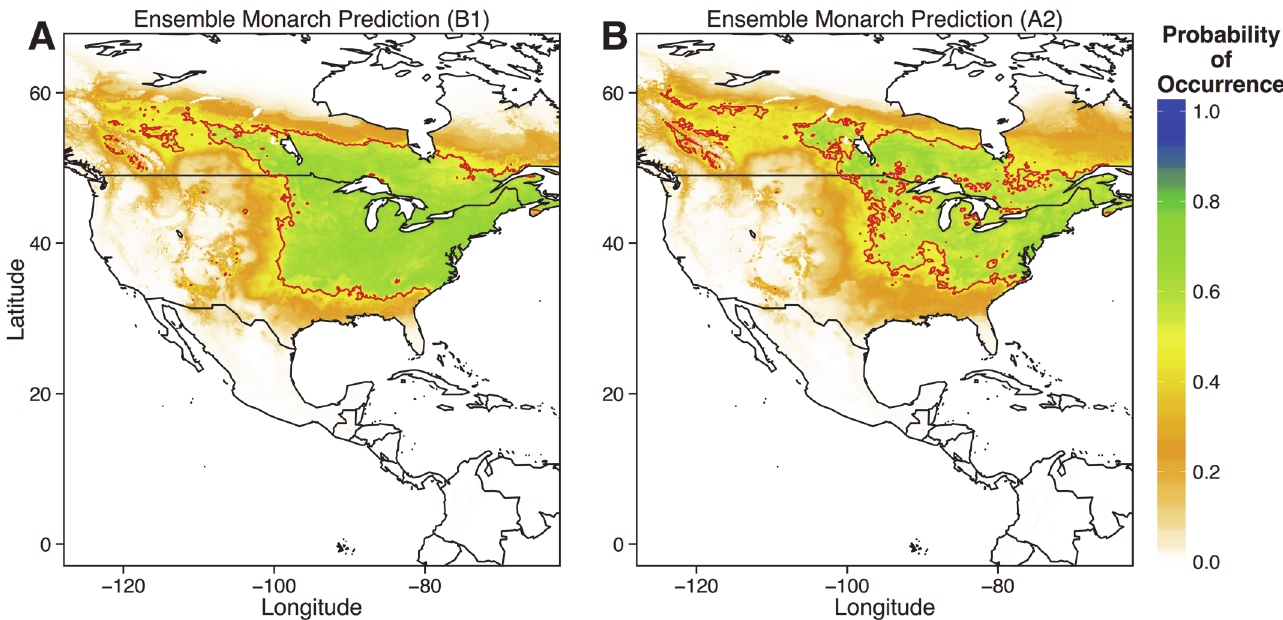
Fig 7. Ensemble predictions of monarch distribution under moderate (B1) and severe (A2) climate change scenarios. Ensemble predictions were created by averaging model output from all four GCM predictions. Predicted occurrence of Asclepias under each climate change scenario was used as a predictor in each model. The thick red line denotes the 0.5 probability contour, such that areas inside the contour have a (cid:1) 0.5 probability of containing